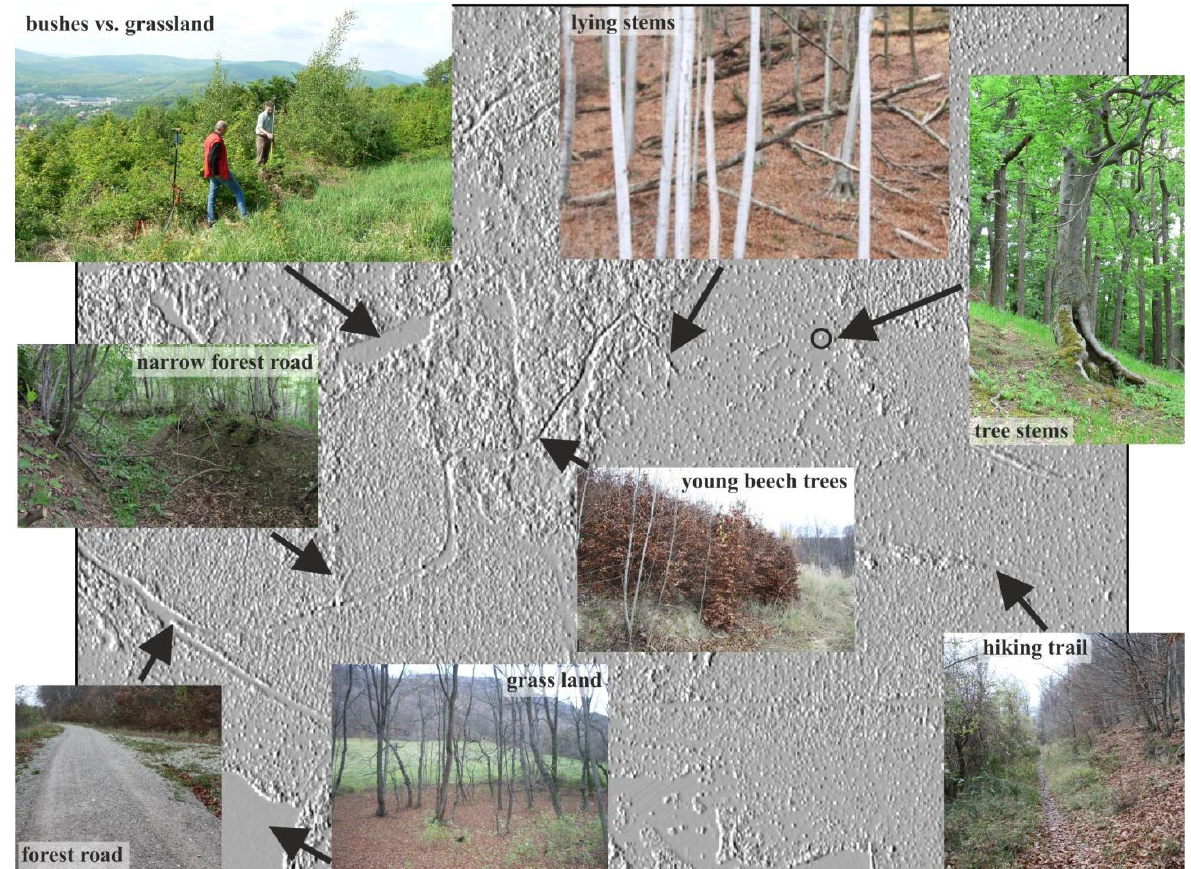
Figure 7. Shading of the standard deviation of the detrended terrain echoes ( d overlaid with pictures from different features.